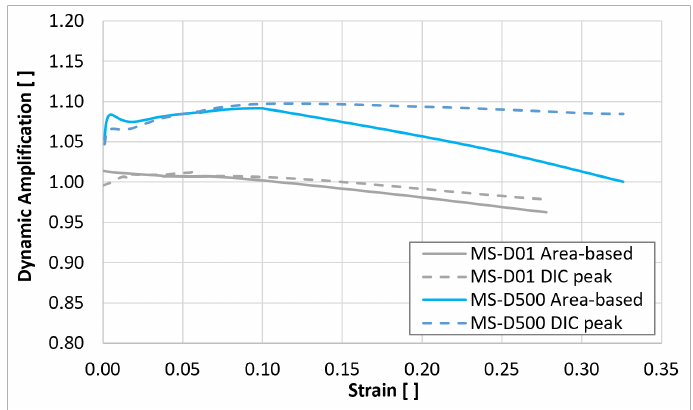
Figure 17. Dynamic amplification histories of tests MS-D01 and MD-D500.